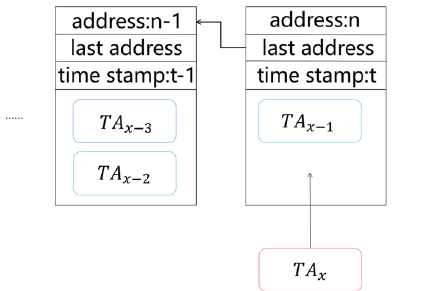
Figure 6. Transactions verified by 2/3 of witnesses can be packaged into a blockchain by the present witness, where the data structure of the blocks is the same as the data structure in Fig. 1, and TA x is a valid transaction that needs to be